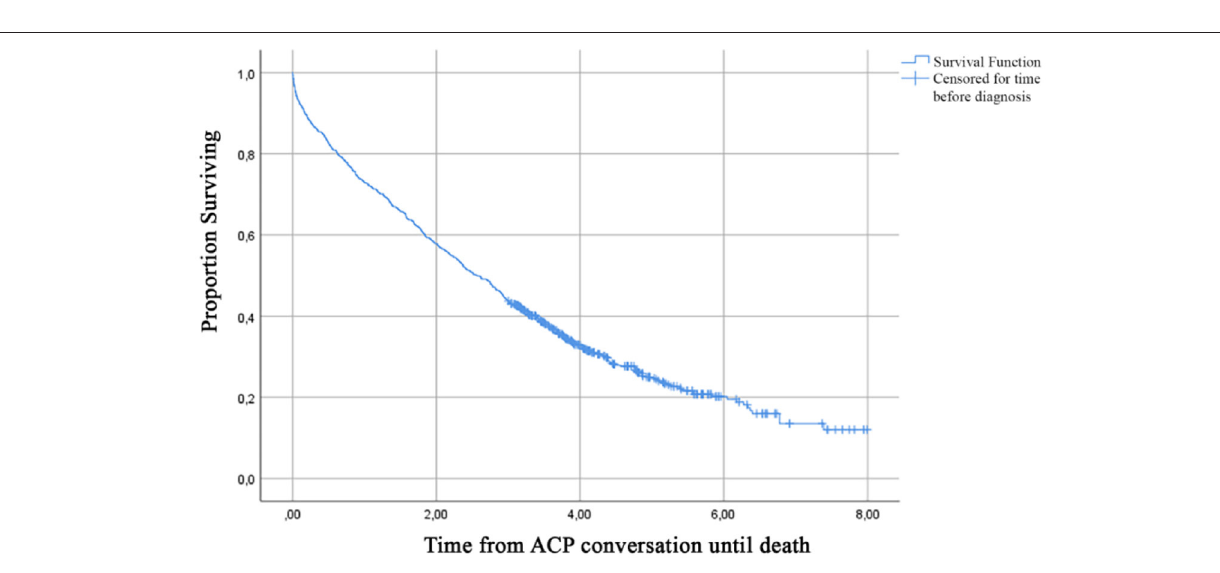
FIGURE 3 | Kaplan Meier curve of time in years from a first recorded ACP conversation until